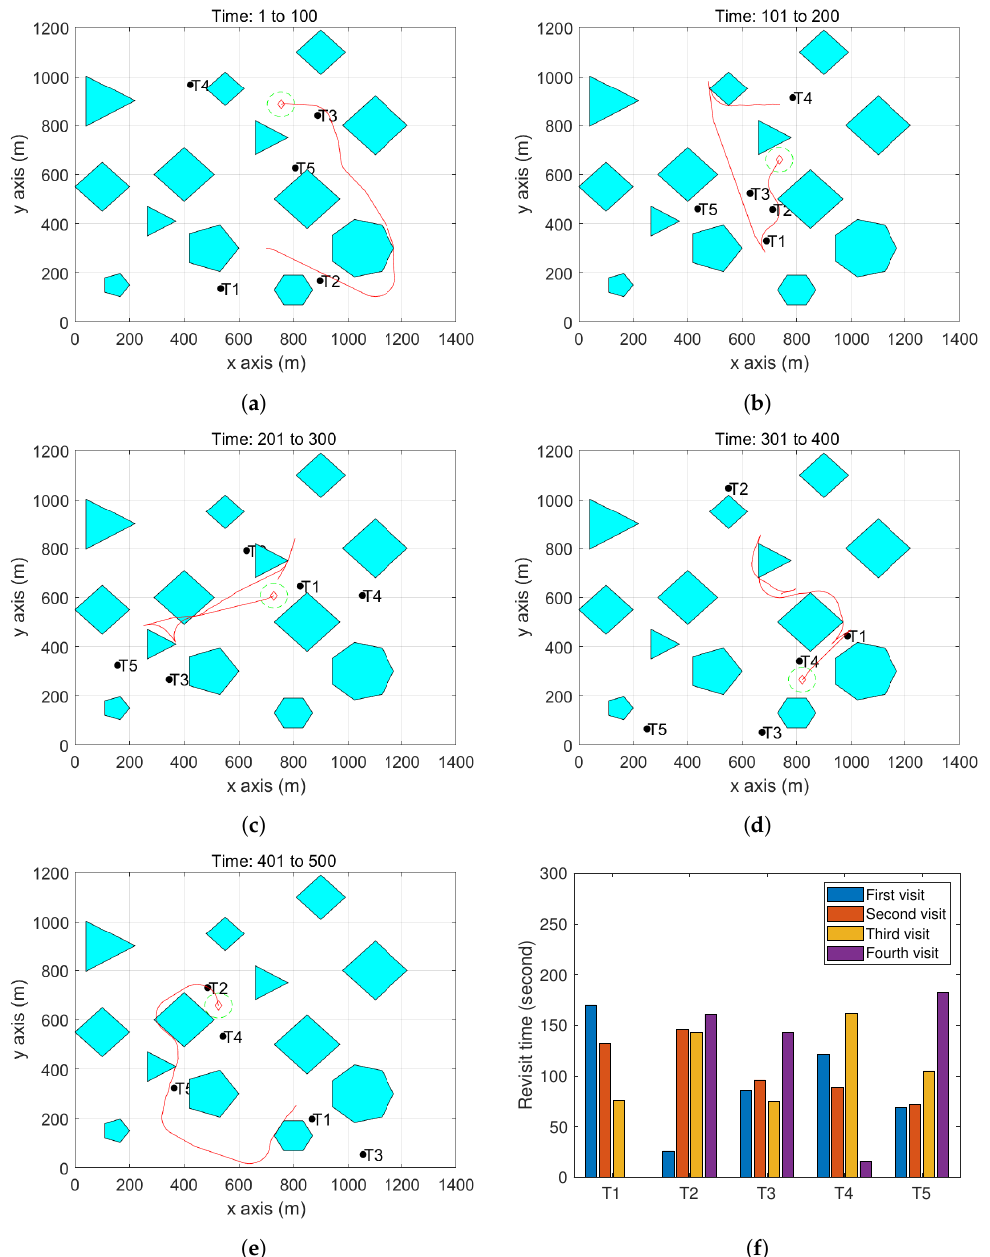
Figure 9. UAV trajectory when flying at 15 m/s. (2D view: https://youtu.be/smvPf-fFdfw; 3D view: https://youtu.be/anSTjbqGoa8).( a ) The UAV trajectory between 1 and 100 s. ( b ) The UAV trajectory between 101 and 200 s. ( c ) The UAV trajectory between 201 and 300 s. ( d ) The UAV trajectory between 301 and 400 s. ( e ) The UAV trajectory between 401 and 500 s. ( f ) The revisit time of each target during the